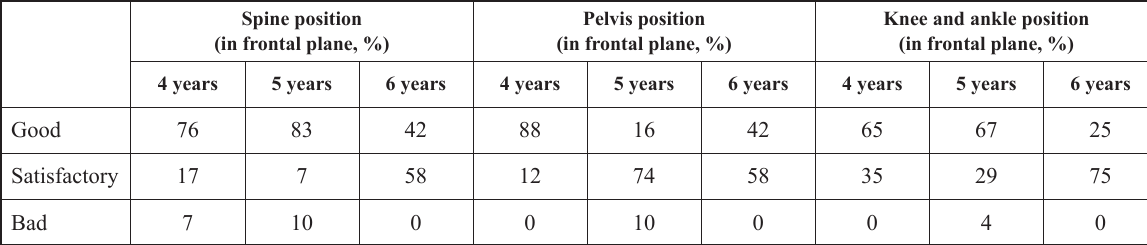
Table 4. Analysis of position of torso, abdomen, lower spine and legs in the age group 4–6-year-old children (%) Torso position (in sagittal plane, %)